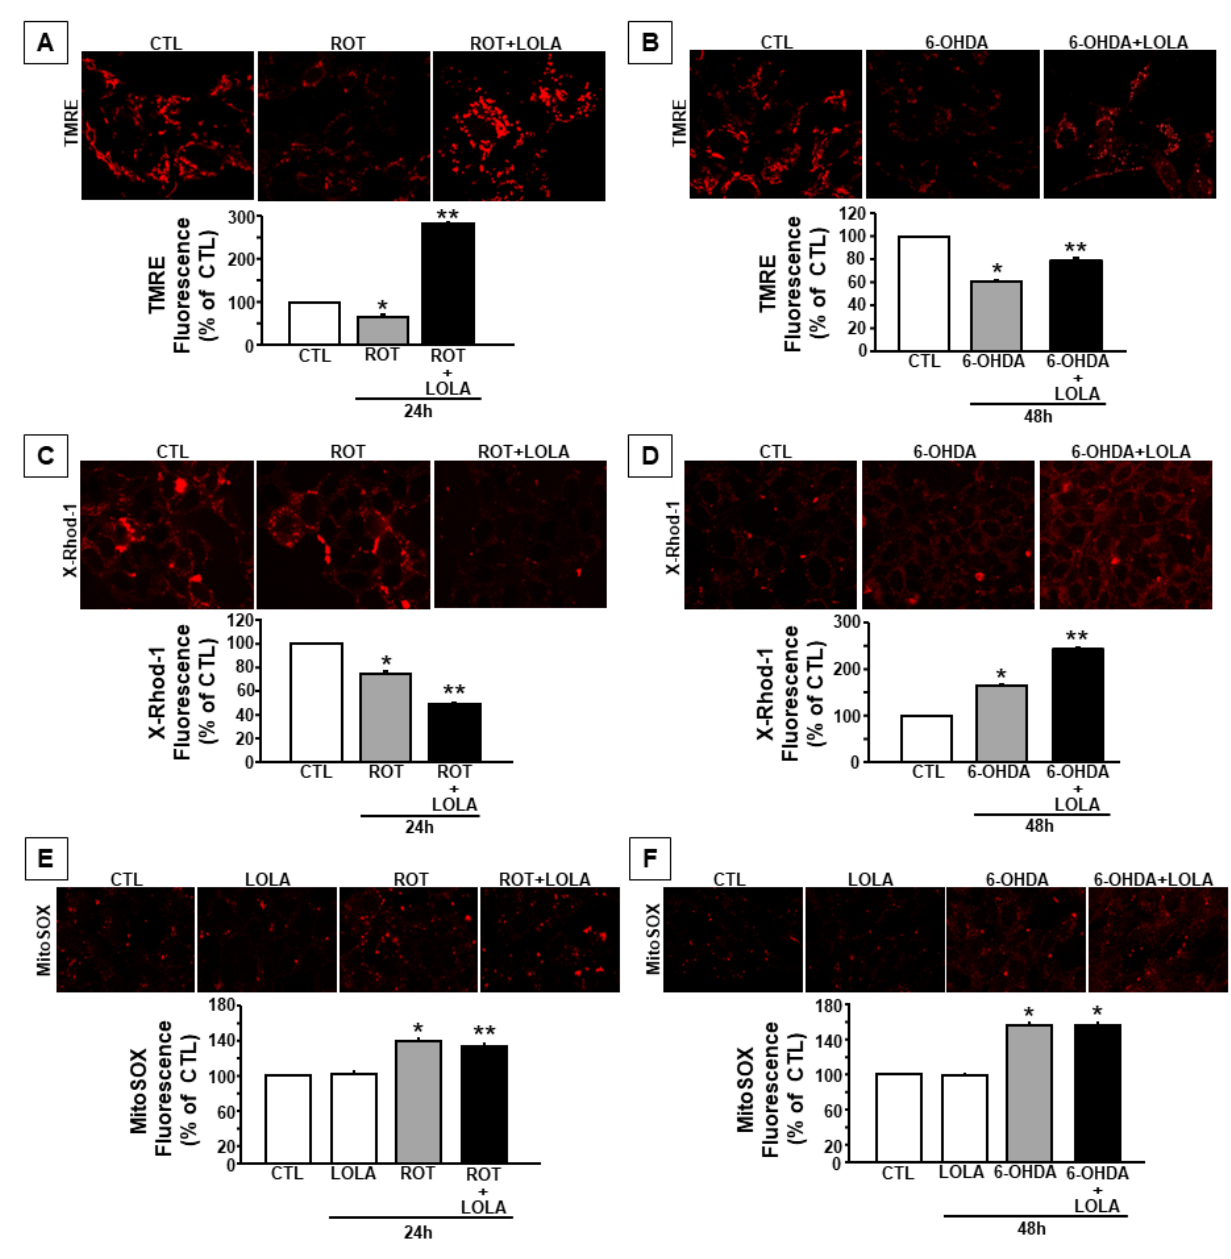
Figure 2. Mitochondrial functional parameters in SH-SY5Y cells exposed to ROT and 6-OHDA in the presence or in the absence of LOLA: ( A ) Quantification of mitochondrial membrane potential in cells treated with ROT (500 nM/24 h) and ROT+LOLA (5 mM/24 h). * p < 0.05 vs. CTL, ** p < 0.05 vs. ROT. ( B ) Quantification of mitochondrial membrane potential in cells treated with 6-OHDA (30 µ M/48 h) and 6-OHDA+LOLA. * p < 0.05 vs. CTL, ** p < 0.05 vs. 6-OHDA. ( C ) Quantification of [Ca 2+ ] m in cells treated with ROT and ROT+LOLA. * p < 0.05 vs. CTL, ** p < 0.05 vs. ROT. ( D ) Quantification of [Ca 2+ ] m in cells treated with 6-OHDA and 6-OHDA+LOLA. * p < 0.05 vs. CTL, ** p < 0.05 vs. 6-OHDA. ( E ) Quantification of ROS production in cells treated with LOLA, ROT, and ROT+LOLA. * p < 0.05 vs. CTL, LOLA; ** p < 0.05 vs. ROT. ( F ) Quantification of ROS production in cells treated with LOLA, 6-OHDA, and 6-OHDA+LOLA. * p < 0.05 vs. CTL, LOLA. Mitochondrial functional parameters were measured at least in 200 cells for each of the 3 independent experimental sessions. Data were expressed as percentage ± S.E.M. Statistical comparisons between control and treated cells were performed using the one-way ANOVA test followed by Newman–Keuls test. The values for each column represent the mean of the percentages ±